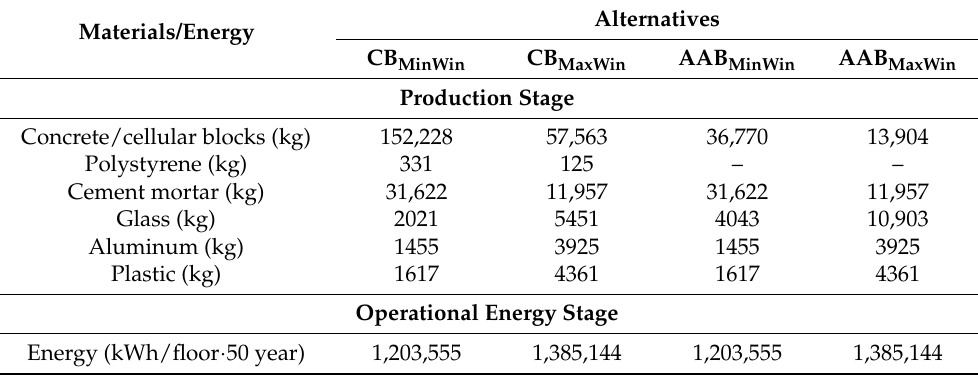
Table 5. Quantities of building materials required for P&R stage and energy required for OE stage of four alternatives (typical intermediate